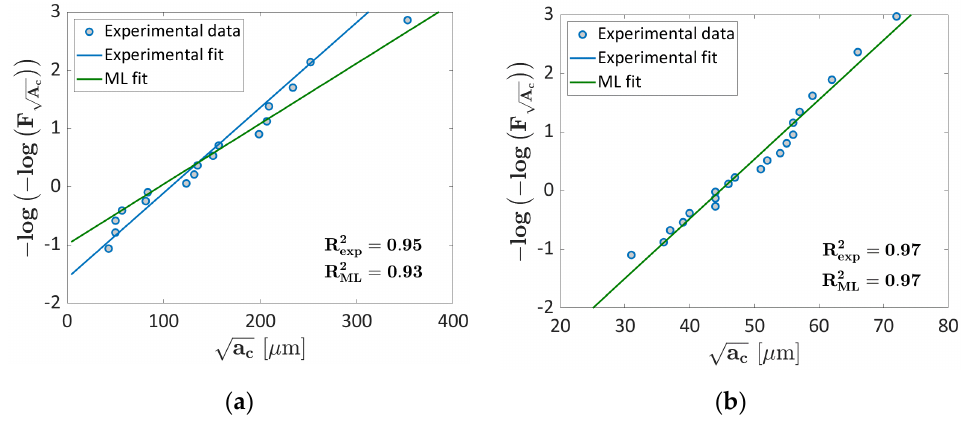
Figure 17. Gumbel plot for k = 1 considered for the validation; ( a ) validation fold; ( b ) training fold.